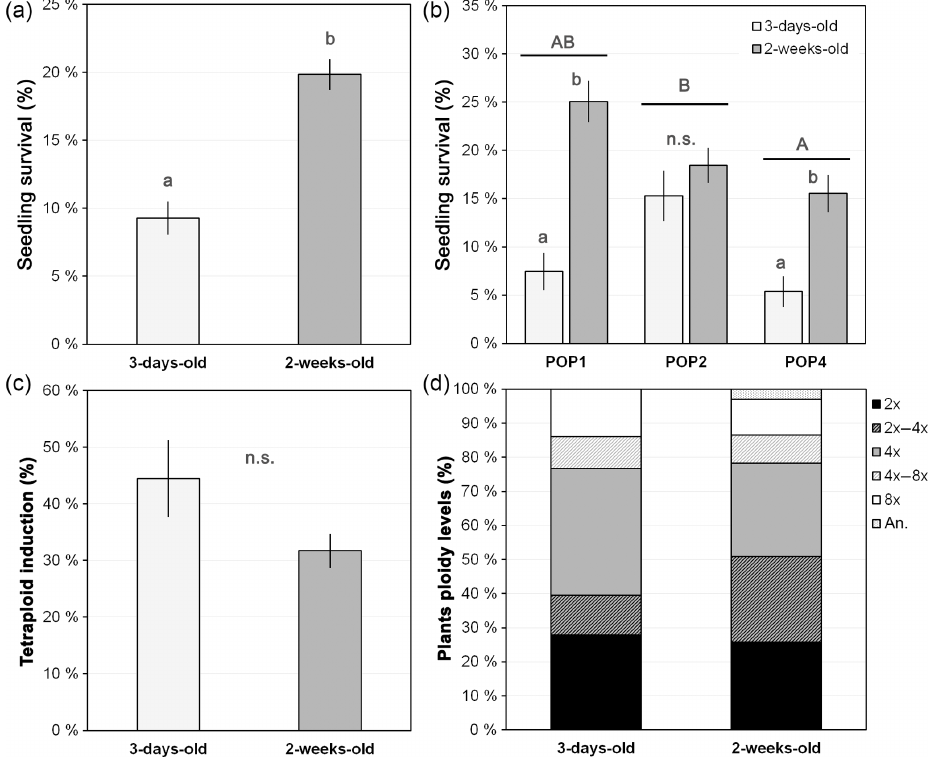
Figure 4. Seedling age effect on seedling survival, synthetic tetraploid induction and ploidy levels of treated seedings. (a) Overall seedling survival for each age category; (b) seedling survival for each age category within each studied population; (c) percentage of synthetic tetraploid induction per age category; and (d) ploidy level of the plants after treating seedlings with different ages with colchicine. Age categories denote the age at which the seedling was treated with colchicine: 3-day-old and 2-week-old seedlings. Ploidy levels: 2 x , DNA diploid; 2 x –4 x , diploid-tetraploid mixoploids; 4 x , DNA tetraploid; 4 x –8 x , tetraploid-octoploid mixoploids; 8 x , DNA octoploid; an., DNA aneuploids. Values are given in percentage as mean and standard error of the mean (in a–c ) or percentage from the total (in d ). Different lower- case letters denote significant differences among treatments, including the total comparison (in a ) and among treatments within population (in b ) at P < 0 . 05; different upper-case letters denote significant differences among populations at P < 0 . 05; n.s. denote non-significant differences between treatments at P > 0 .